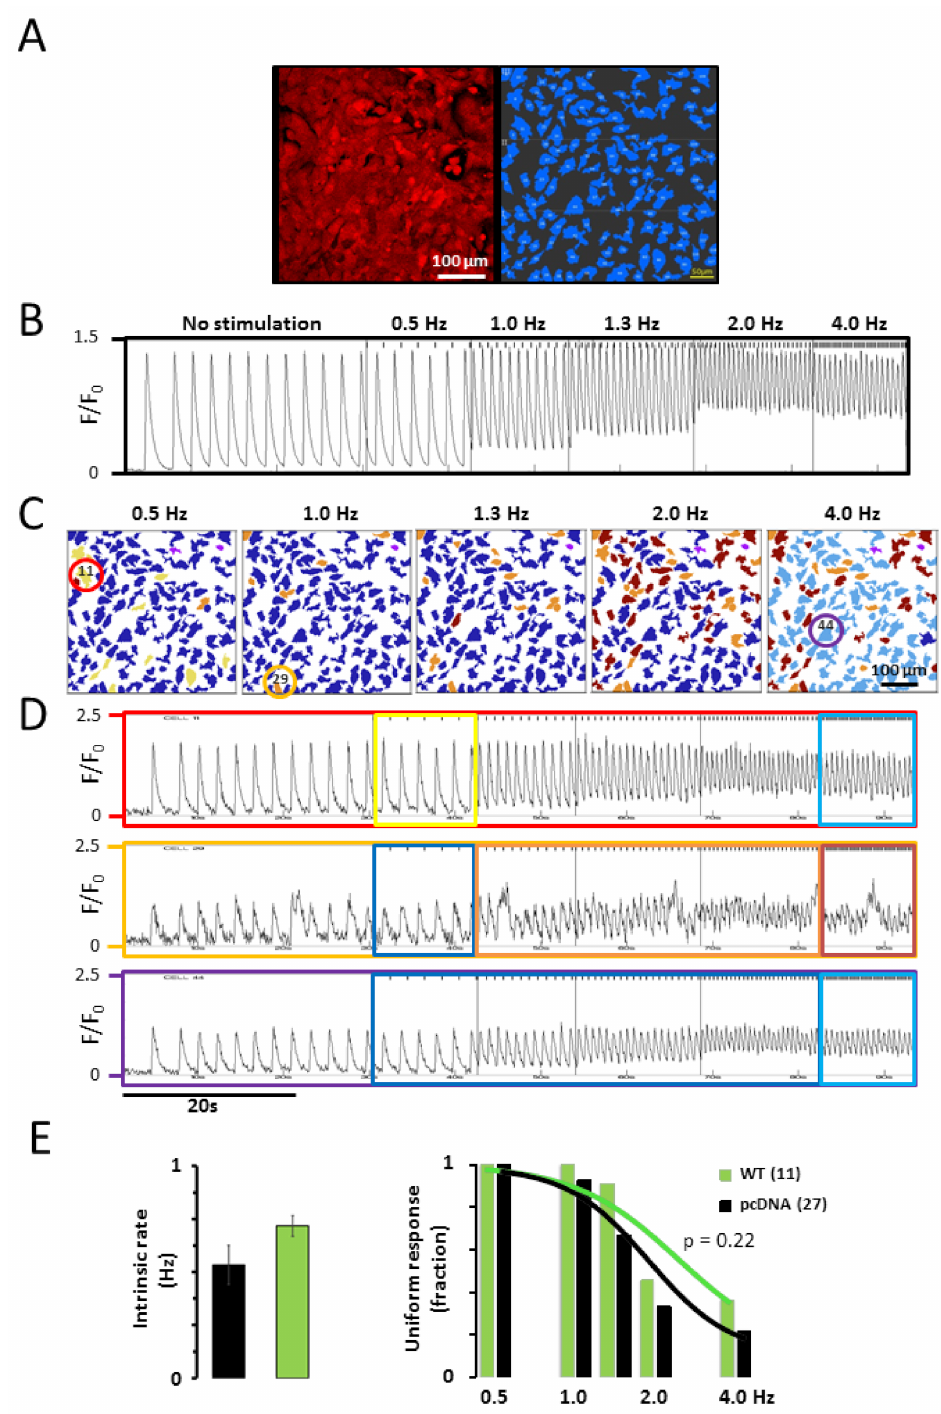
Figure 5. Calcium transient recordings in HL1 myocyte cultures. Panel ( A ). Calcium imaging in Cal-590 loaded HL1 myocytes (left) and automatic detection of myocytes with calcium signal (right). Panel ( B ). Calcium transient recorded in pcDNA transfected myocytes before (no stimulation) and after electrical field stimulation at the stimulation frequencies indicated above traces. Panel ( C ). Automatic classification of the calcium signals in individual HL1 myocytes. Color code indicates uniform (blue), alternating (yellow), block (light blue), waves (orange), or irregular (brown) beat-to- beat response. Panel ( D ). Responses of myocytes #11 (red), #29 (orange) and #44 (purple). Panel ( E ). The intrinsic beating rate (left) and the fraction of fields responding uniformly (right) were similar in cultures transfected with pcDNA and WT Pitx2. Number of experiments is given in